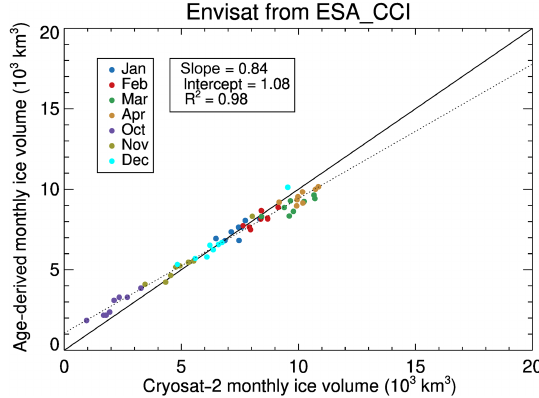
Figure 11. Same as Fig. 10 except for ice